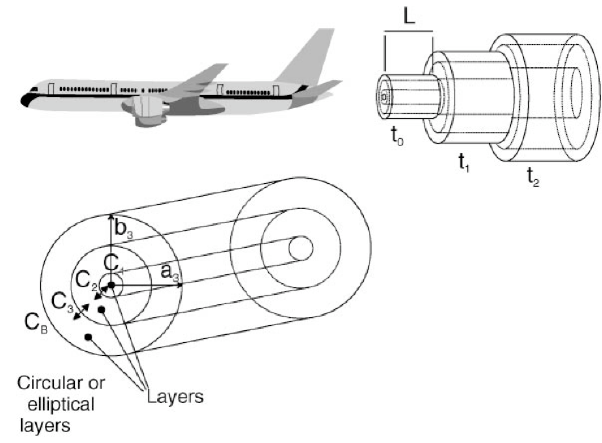
Fig. 2. Sketch of ship plume evolution in the marine boundary layer (von Glasow et al., 2003).